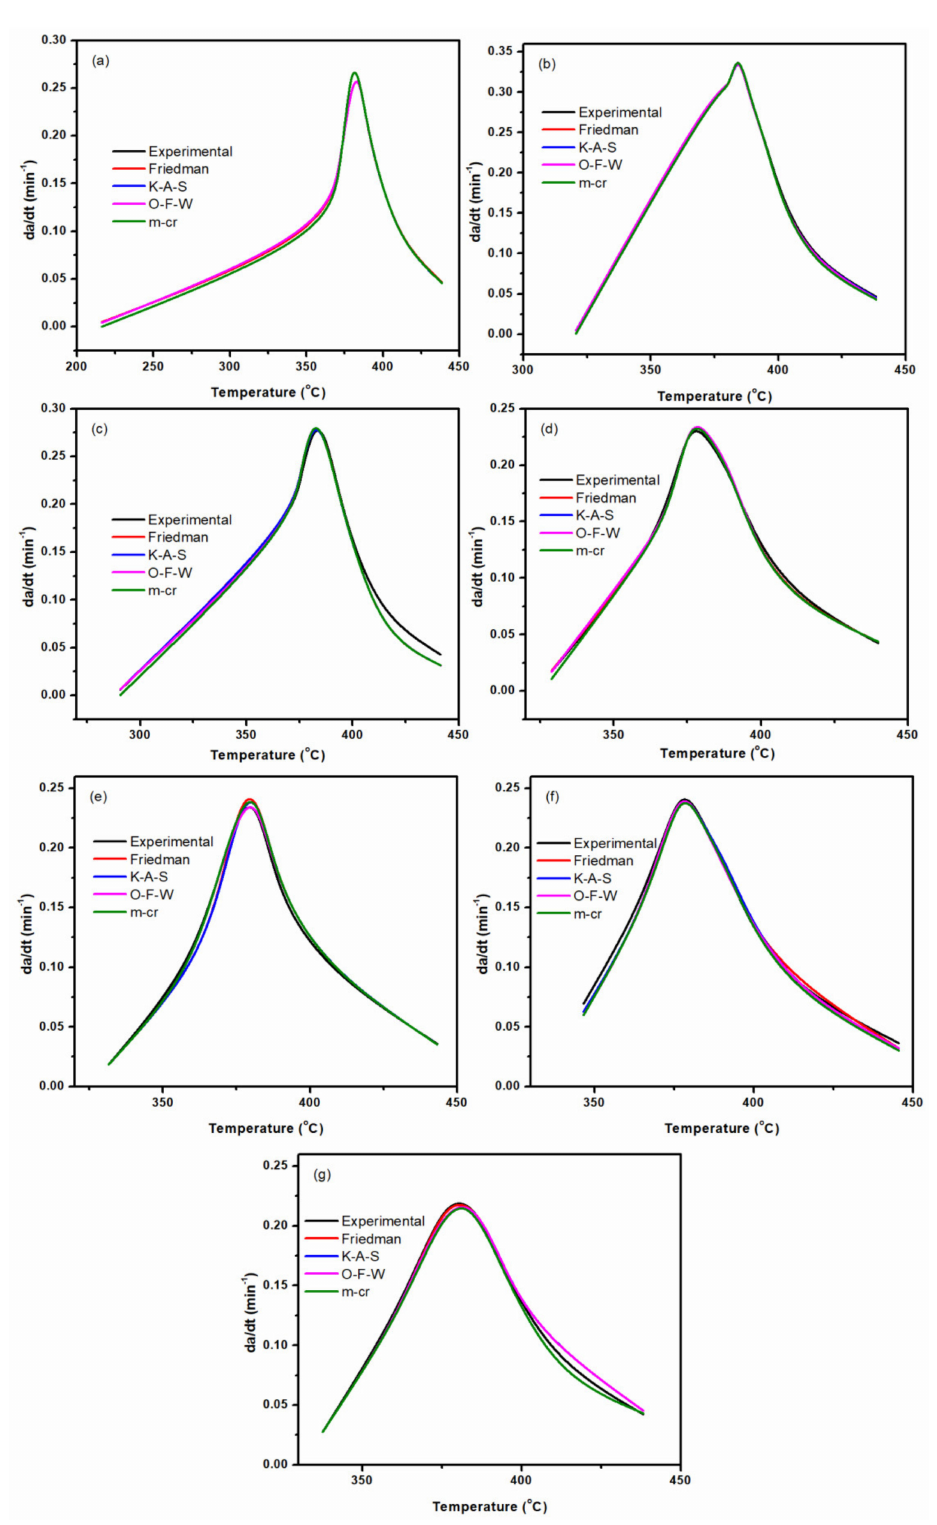
Figure 15. Typical comparison between the experimental and isoconversional approaches at a heating rate of 5 ◦ C min − 1 for samples E0 ( a ), EP/Mica–0.5 ( b ), EP/Mica–2 ( c ), EP/Mica–5 ( d ), EP/Mica–IM–0.5 ( e ), EP/Mica–IM–2 ( f ), and EP/Mica– IM–5 ( g )